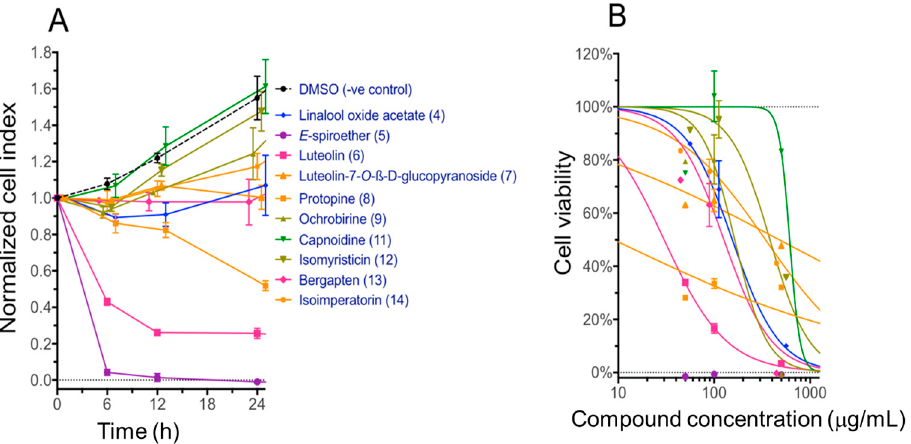
Figure 4. Cytotoxicity of selected plant compounds against immortalized H69 bile duct cells determined by xCELLigence system (ACEA Biosciences Inc.). ( A ) Cell toxicity over time as recorded by normalized cell index when treated with selected compounds. ( B ) Dose response toxicity curves at the 24 h time point show cell viability relative to the untreated control against concentration. Compounds 1 – 3 and 10 were not tested for cytotoxicity due to insufficient quantities available at the time of the study.